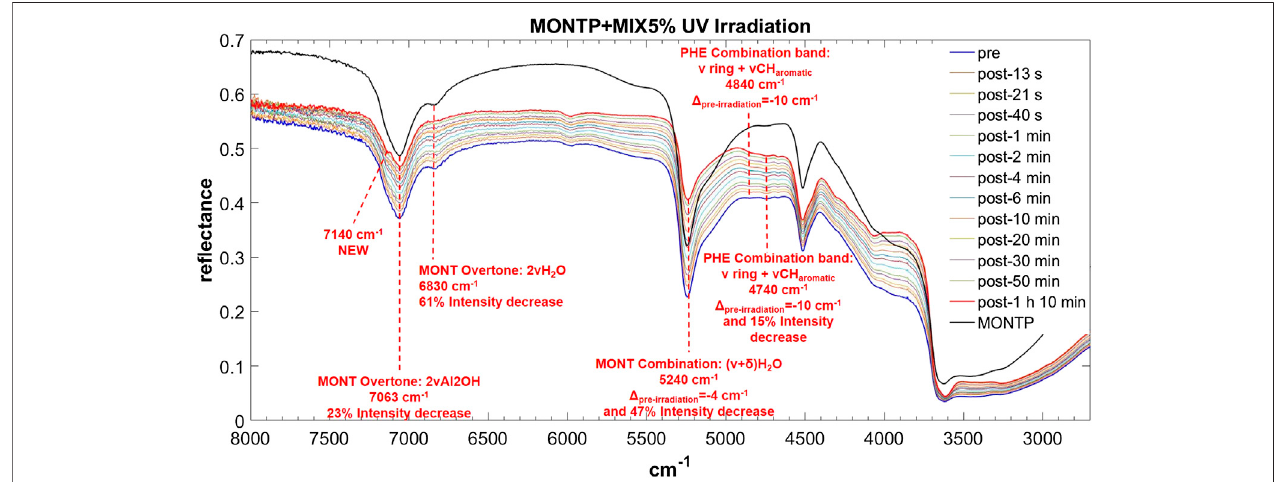
FIGURE 12 | Main changes in NIR features after 70 min of UV irradiation for MIX 5 wt% on montmorillonite containing 1 wt% of Mg-perchlorate. Legend: Δ pre-irr (cid:2) wavenumber shift with respect to the same peak pre-irradiation; ν (cid:2) stretching vibrational mode; δ (cid:2) bending vibrational mode.